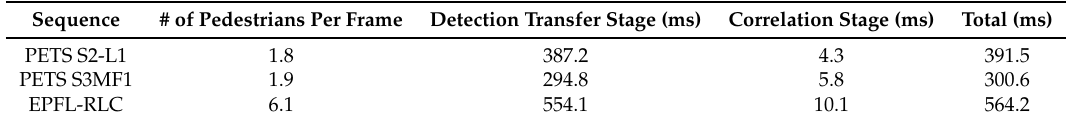
Table 5. Computational cost results obtained with the faster R-CNN detections [13] per frame in milliseconds (ms) of both the transfer and correlation stages of each video